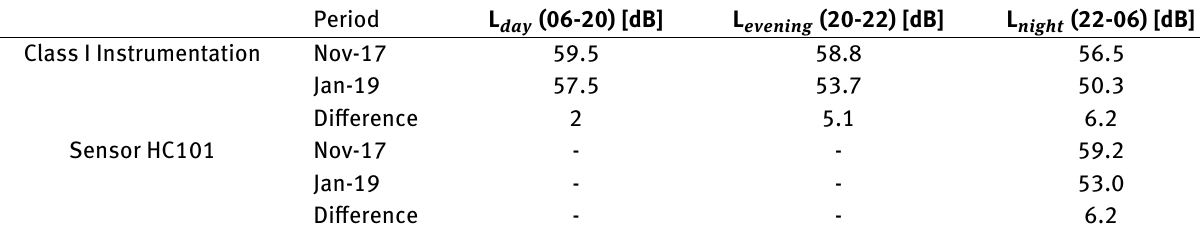
Table 3: Comparison of the results obtained for the acoustic descriptor L day , L evening and L night between the two measurement systems used in the monitoring of the ante and